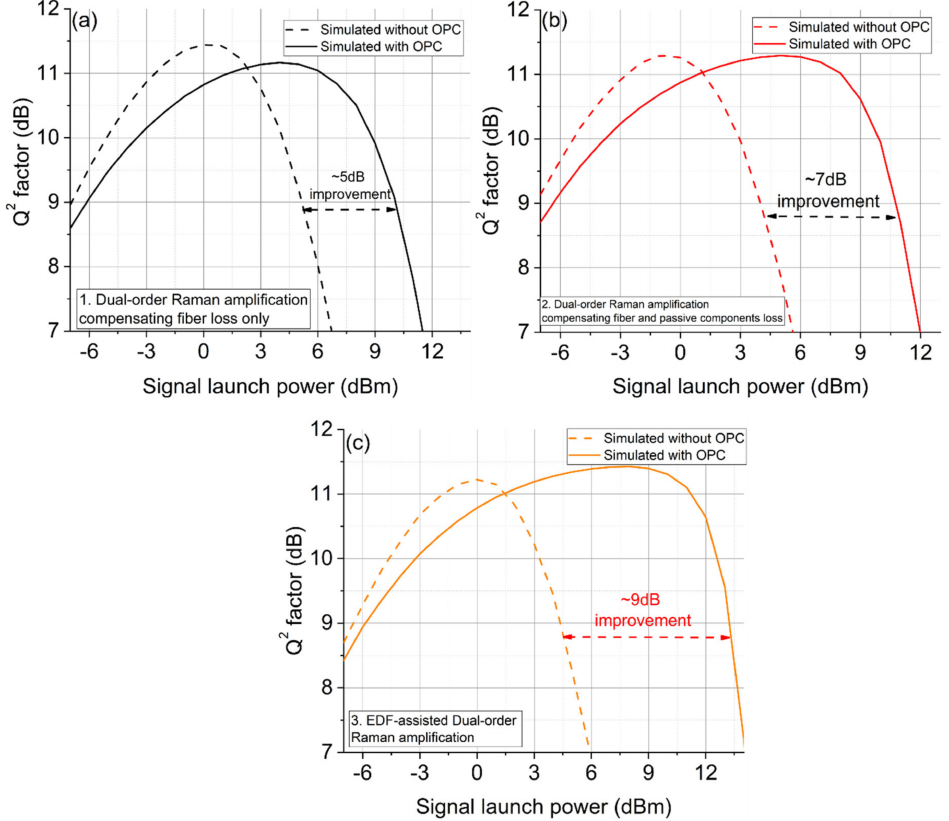
Figure 15. Q 2 factors versus signal launch power in inline transmission systems without/with OPC using the optimized dual-order DRA scheme at 200 km. Dotted lines—no OPC, solid—with OPC. ( a ) No account of loss, ( b ) accounting for loss with excess Raman gain, ( c ) accounting for loss with